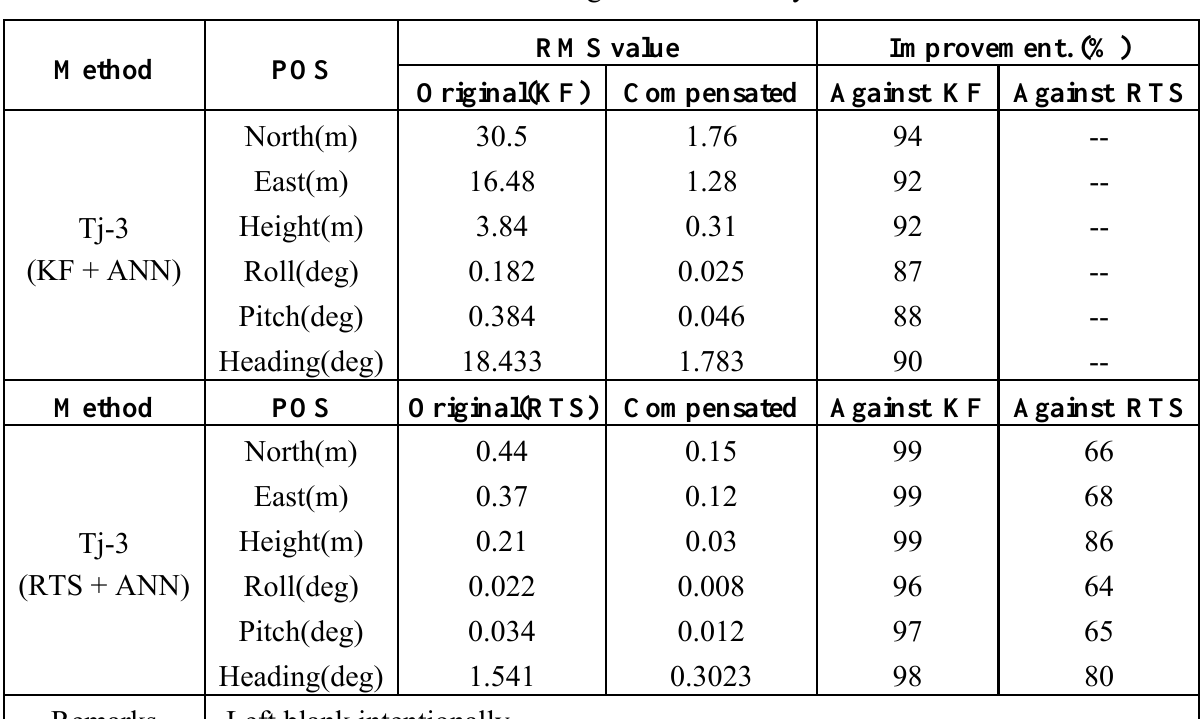
Table 2. Training results